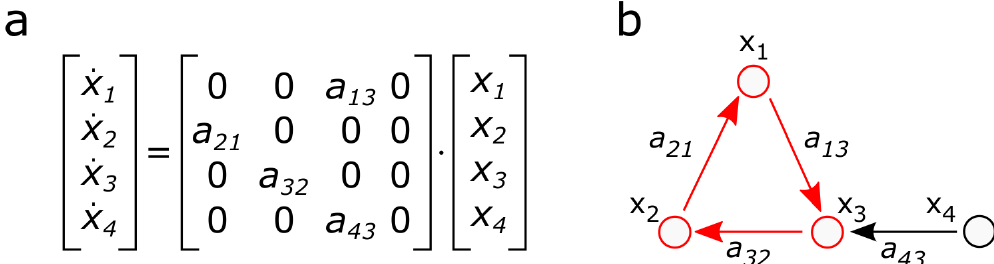
Figure 2. ( a ) example system x ( t ) = A x ( t ) ; ( b ) graph representation of ( a ); state variables { x 1 , x 2 , x 3 } are matched by MM = { a 13 , a 21 , a 32 } = { ( x 1 , x 3 ) , ( x 2 , x 1 ) , ( x 3 , x 2 ) } and the system is